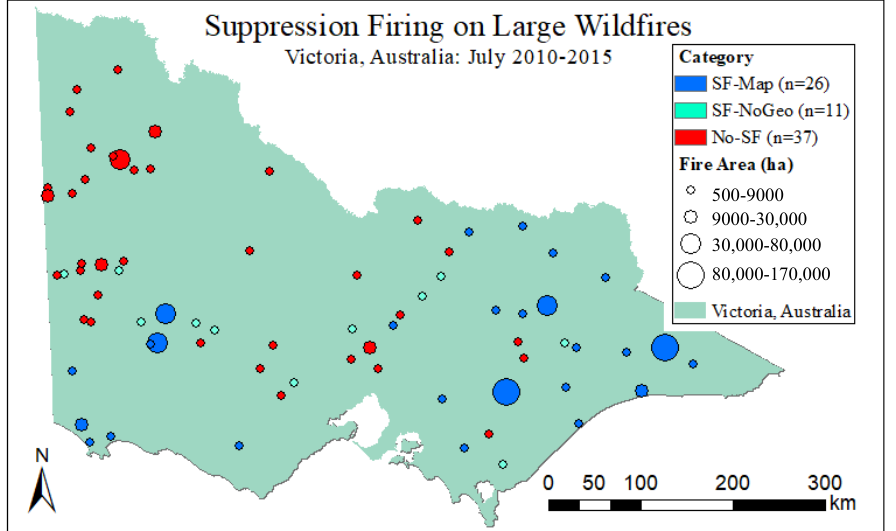
Figure 1. Point locations of the 74 fires in our study. Point size is indicative of final fire area in hectares. Point color is indicative of three categories of suppression firing, fires colored: (1) SF-Map (blue) had sufficient data to map the suppression firing, (2) SF-NoGeo (turquoise) had suppression firing but there was insufficient geographic data to map the extent, and (3) No-SF (red) had no evidence of suppression firing.